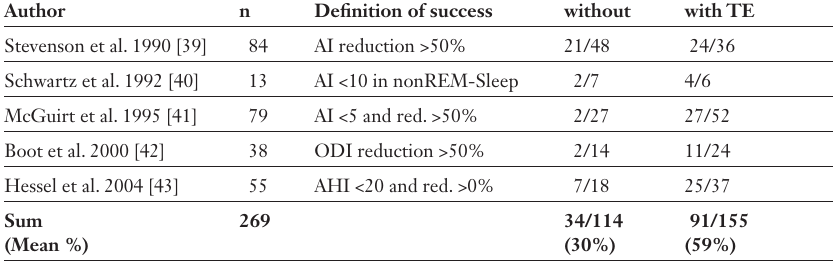
Impact of tonsillec- tomy on UPPP out- come (short-term re- sults). AI = apnoea index; ODI = oxygen desatu- ration index; AHI = apnoea-hypopnea index;TE = tonsillec-